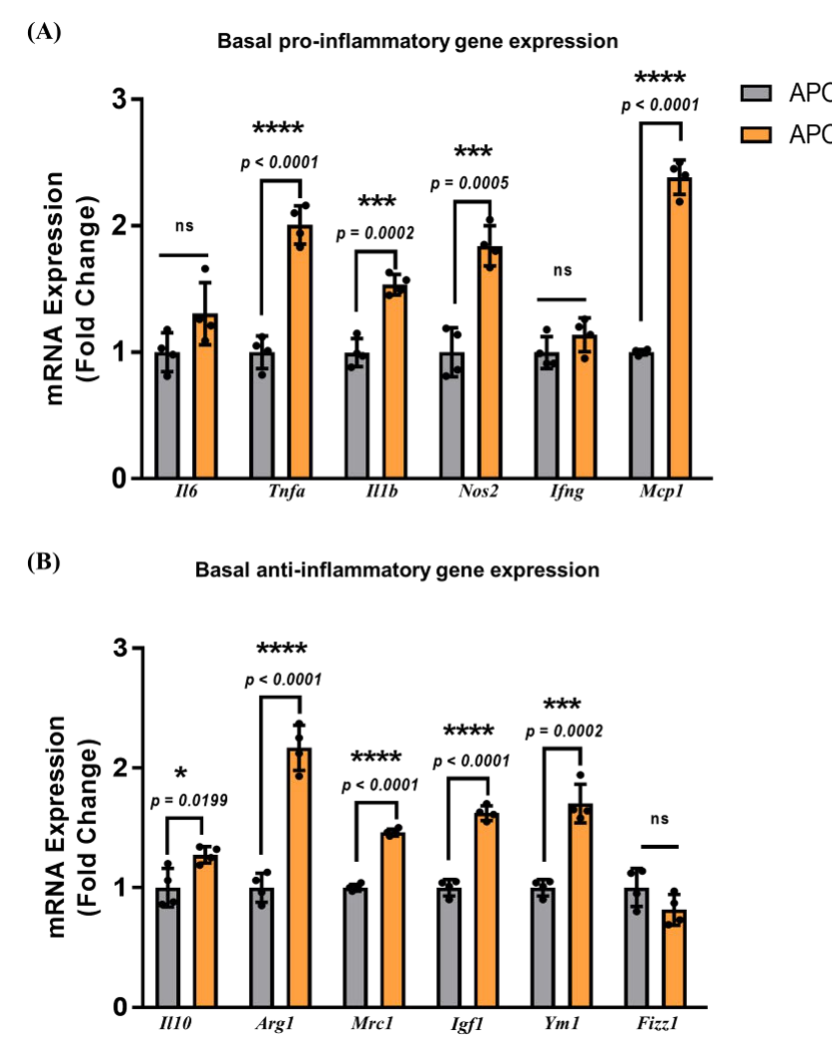
Figure 2. Basal pro − and anti − inflammatory gene expression in mixed − sex microglia is APOE genotype − dependent: ( A ) basal pro − inflammatory and ( B ) anti − inflammatory gene expression was evaluated in non − stimulated mixed − sex microglia from APOE3 and APOE4 genotypes. Gene expression between genotypes was analyzed using an unpaired Student’s t − test (N = 3 isolations, n = 6 plates). Data are represented as the mean ± standard deviation. *, ***, and **** indicate statistical significance for the comparison and denote p < 0.05, 0.001, and 0.0001, respectively. ns = not statistically significant ( p > 0.05).